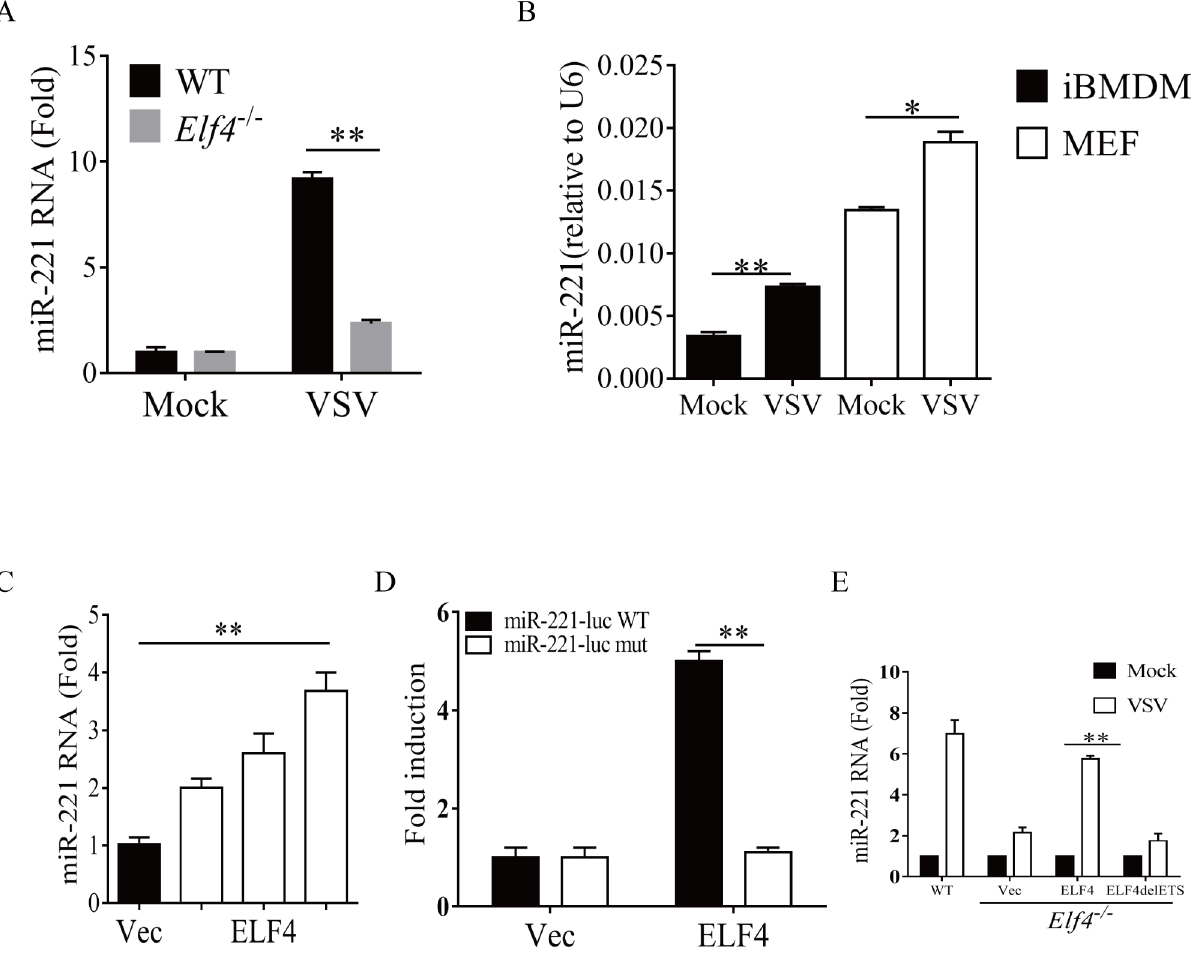
Fig 2. ELF4 promotes miR-221 expression through direct promoter binding. A. Wild type (WT) or Elf4 ─ / ─ peritoneal macrophages were infected with VSV. 12 hours later miR-221 was analyzed by quantitative PCR. (B) iBMDM or MEF cells were infected with VSV. 8 hours later, miR-221 transcripts were measured by q-PCR. (C) HEK 293T cells were transfected with empty vector (Vec) or increasing amounts of ELF4 (50ng, 100ng, 200ng). 24 hours later miR-221 transcript levels were analyzed by quantitative PCR. (D) HEK 293T cells were transfected with miR-221 promoter- driven luciferase plasmids (wild type or mutant), and empty vector (Vec) or ELF4. (E) Wild type (WT) or Elf4 ─ / ─ iBMDM (immortalized Bone marrow derived macrophage) cells were infected with ELF4 or ELF4-del ETS lentivirus, and 24 hours later were infected with VSV. The data are expressed as the mean ± SEM of 4 independent experiments. (n = 4 biological